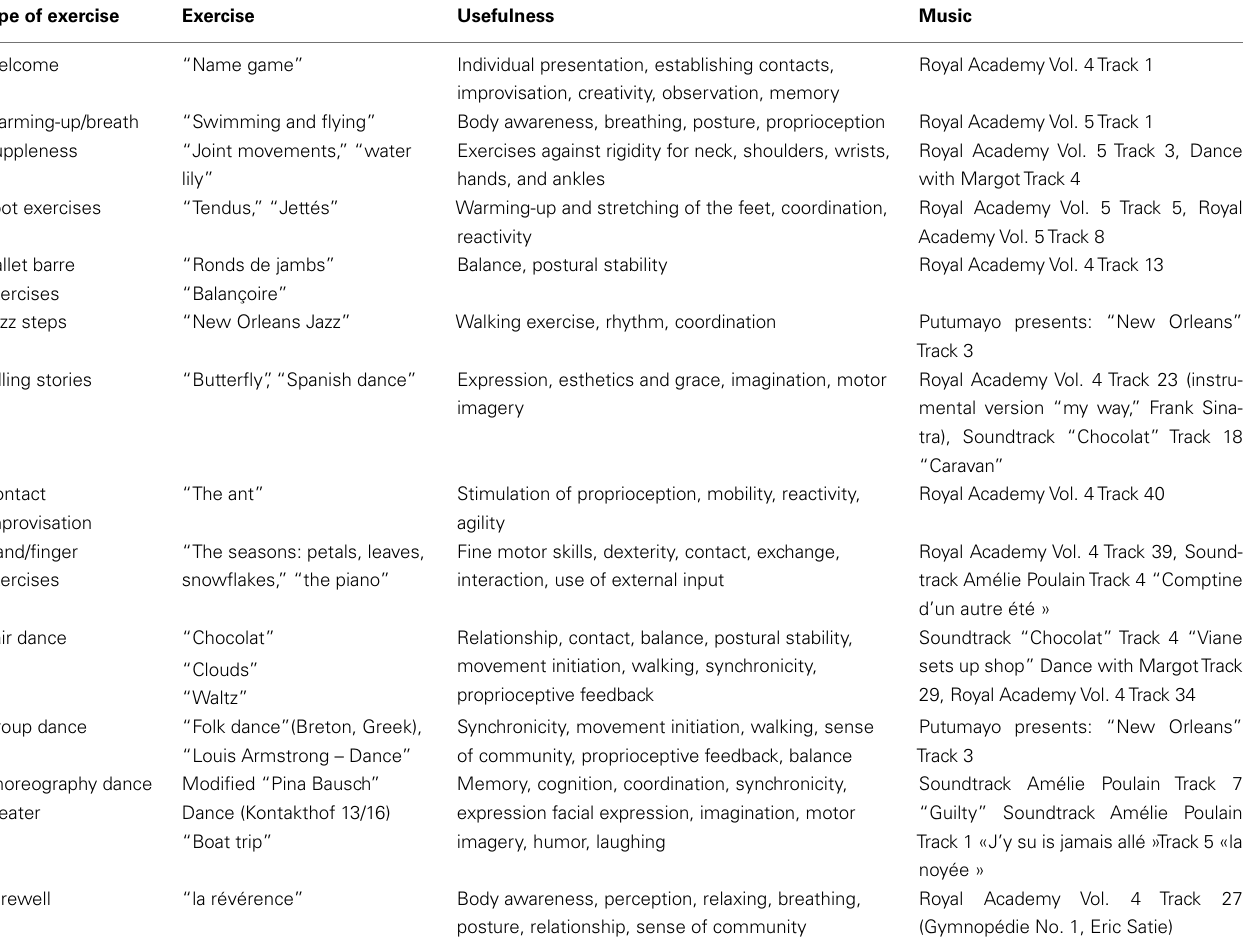
Table 2 | Dance elements in their sequential